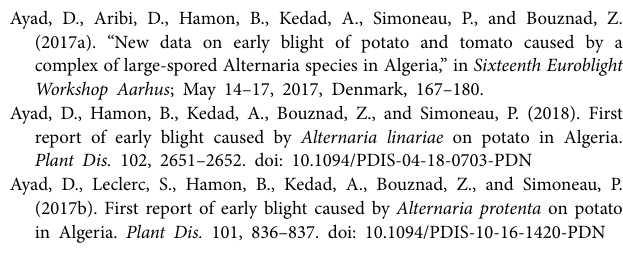
Supplementary Figure 2 | Phylogenetic tree based on maximum likelihood analysis of the calmodulin genes of Alternaria strains from potato and Alternaria reference strains from NCBI data base. Bar: the estimated nucleotide substitutions per site are 0.05. The numbers near each branch represent percentages out of 1,000 bootstrap replications. Supplementary Figure 3 | Phylogenetic tree based on maximum likelihood analysis of the GAPDH genes of Alternaria strains from potato and Alternaria reference strains from NCBI data base. Bar: the estimated nucleotide substitutions per site are 0.01. The numbers near each branch represent percentages out of 1,000 bootstrap replications. Supplementary Figure 4 | Phylogenetic tree based on maximum likelihood analysis of the Rpb2 genes of Alternaria strains from potato and Alternaria reference strains from NCBI data base. Bar: the estimated nucleotide substitutions per site are 0.1. The numbers near each branch